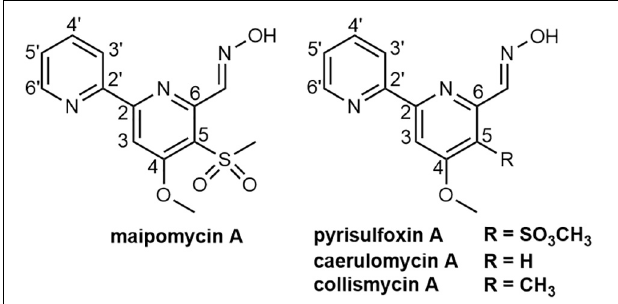
FIGURE 1 | Chemical structures of maipomycin A and its analogs pyrisulfoxin A, caerulomycin A, and collismycin